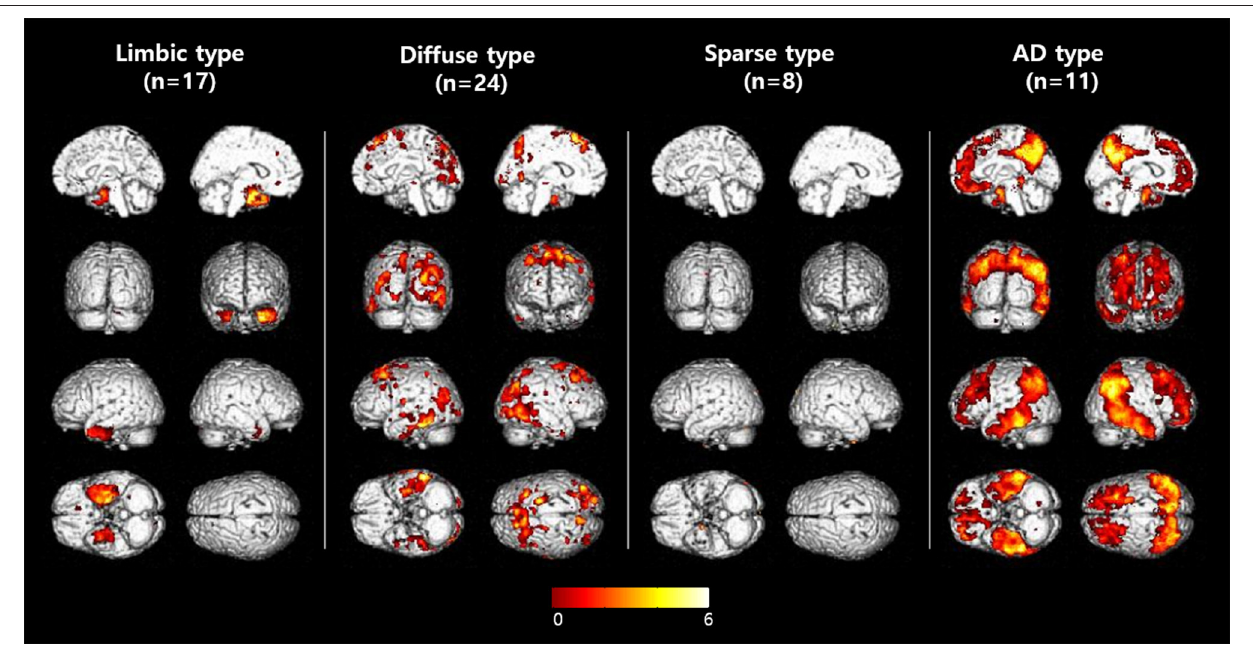
FIGURE 2 | Voxelwise comparisons of [ 18 F]THK5351 retention among MCI subtypes. Voxelwise comparisons of [ 18 F]THK5351 retention between each MCI group to the control group (uncorrected for multiple comparisons with adjustment for age and years of education at a threshold of p < 0.001).